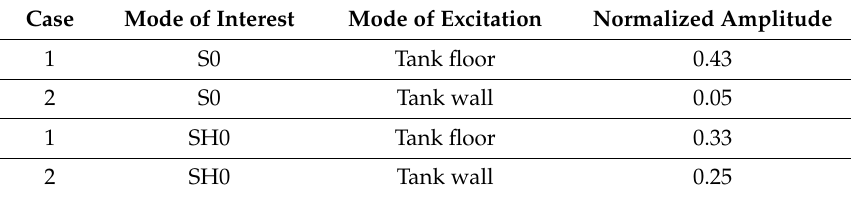
Table 2. Amplitude of each mode of interest for the both cases studied in the numerical analysis.